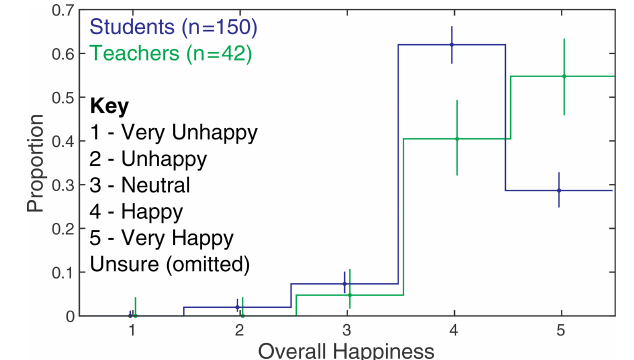
Figure 3. Distribution of students’ (blue) and teachers’ (green) overall happiness with their PRiSE projects. Error bars denote stan- dard (1 σ ) Clopper and Pearson (1934)